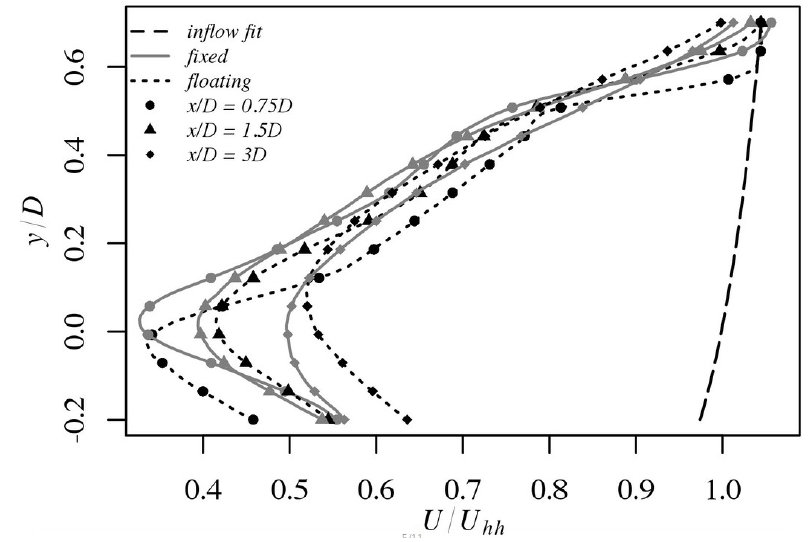
Figure 4. Profile of a logarithmic fit to inflow and near wake profiles of U/U and floating case at downstream distances 0.75 D , 1.5 D and 3 D .